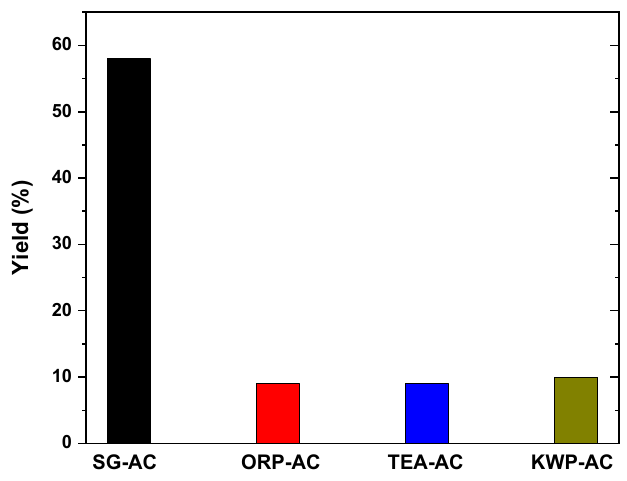
Figure 7. Yield (%) of the prepared AC